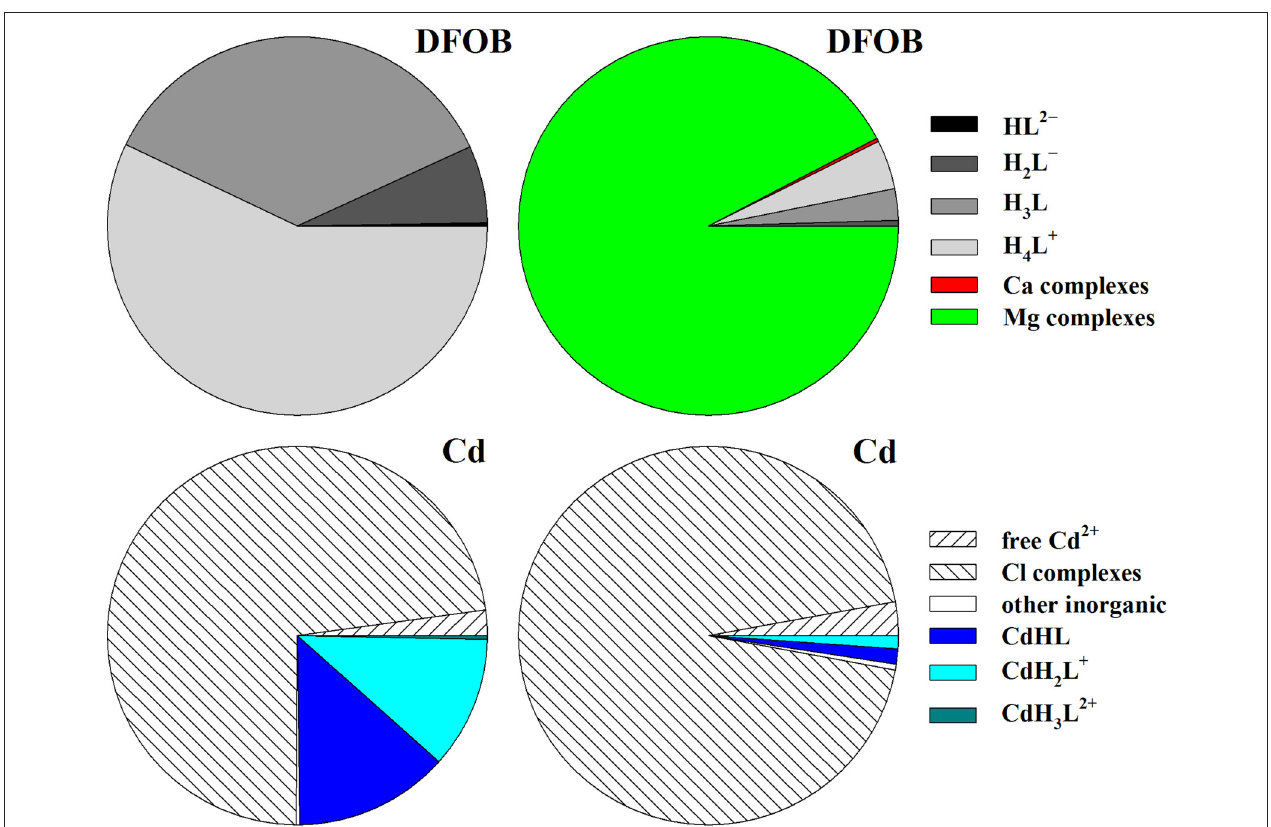
FIGURE 3 | Speciation in seawater ( S = 35, T = 25 ◦ C) of 10 pM DFOB (top) and of 1 pM Cd (bottom), calculated with MINEQL and shown as fractions of the total concentration. For Cd, the free concentration of the species HL 2 − was arbitrarily fixed at a value where DFOB complexes comprise about 25% of the total metal concentration. Diagrams on the left do not account for DFOB complexation with Mg and Ca. In diagrams on the right the calculations are repeated with Mg–DFOB and Ca–DFOB complexes explicitly included. Wedges with the word “complexes” are the sum of multiple species. The wedge “other inorganic” refers to Cd complexes with sulfate and carbonate. Species contributing < 0.3% cannot be resolved in the